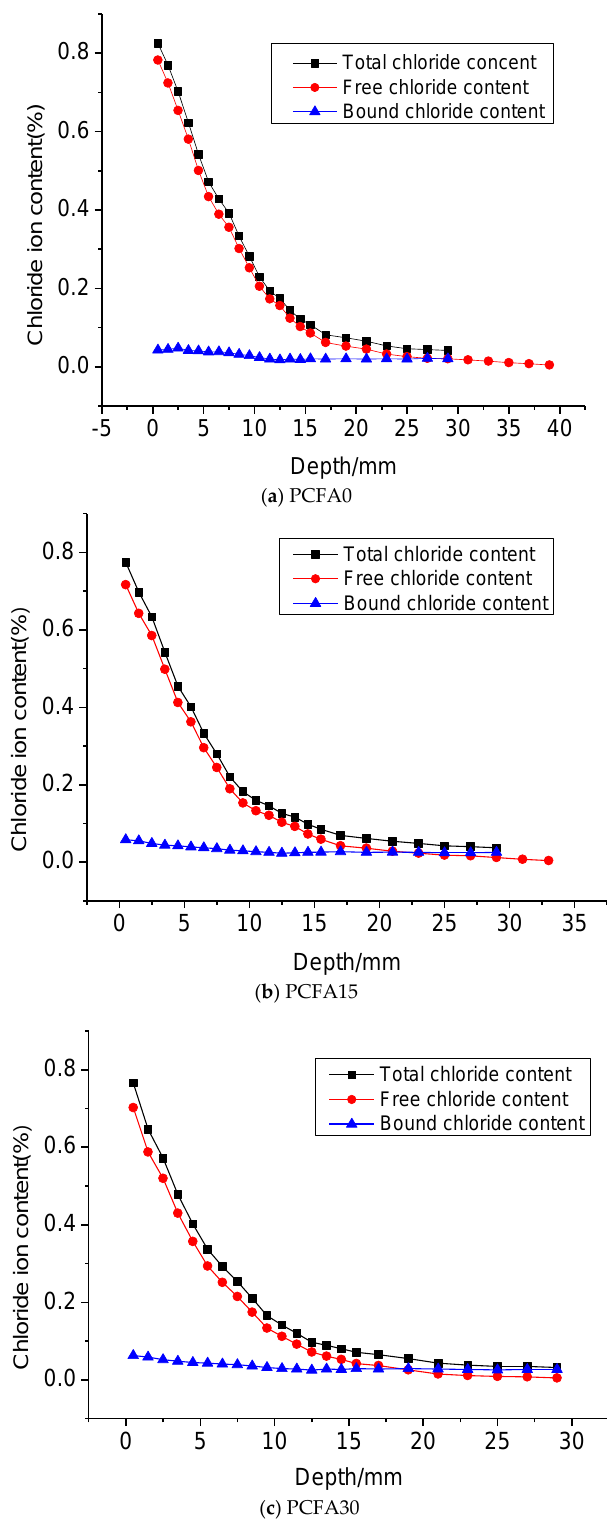
Figure 5. Distribution of total chloride, free chloride, and bound chloride in concrete samples (by mass%).